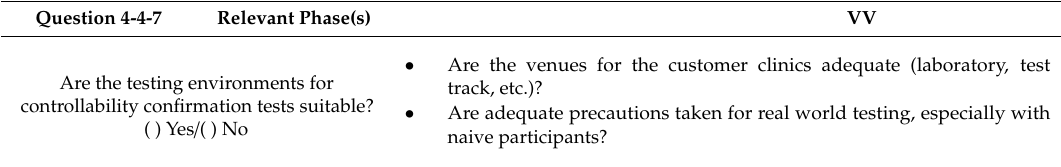
Table 7. Example question for Controllability and Customer